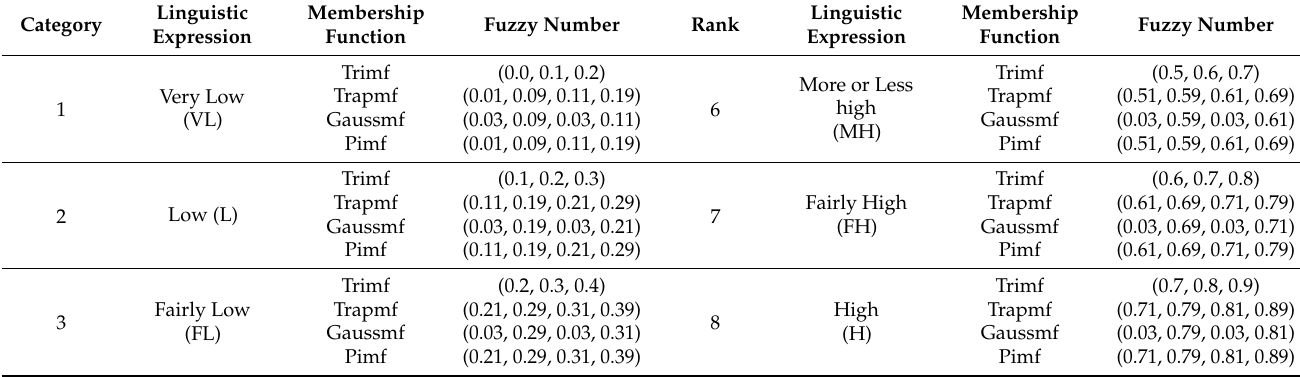
Table 5. 10-scale fuzzy number with 4 membership